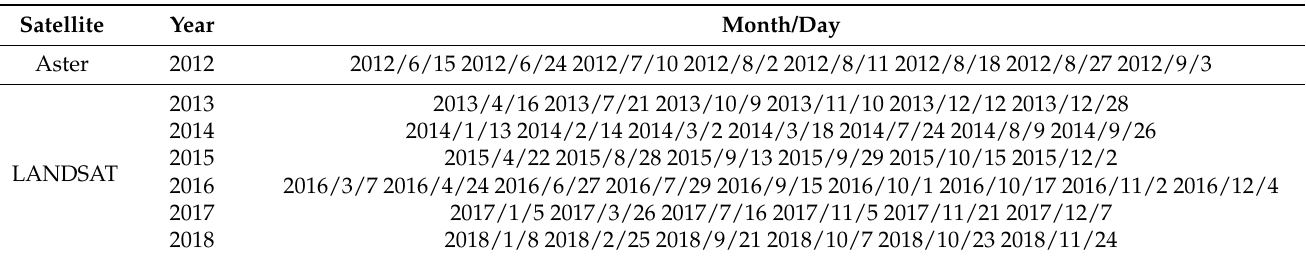
Table 2. Nearly cloud-free Aster and LANDSAT scene imagery used in this study. Satellite Year